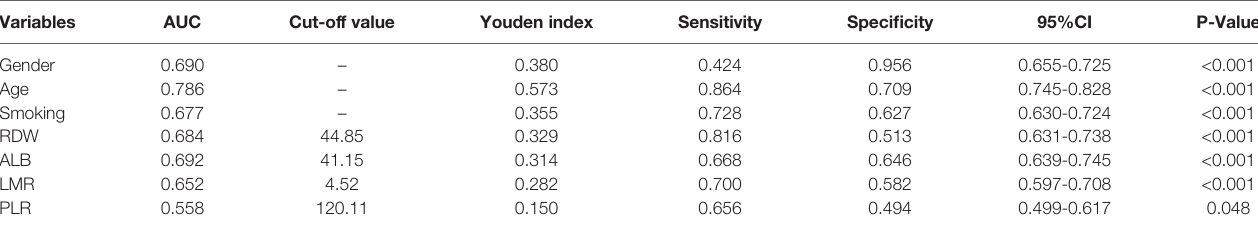
TABLE 3 | The Results of receiver operating characteristic (ROC) curve.